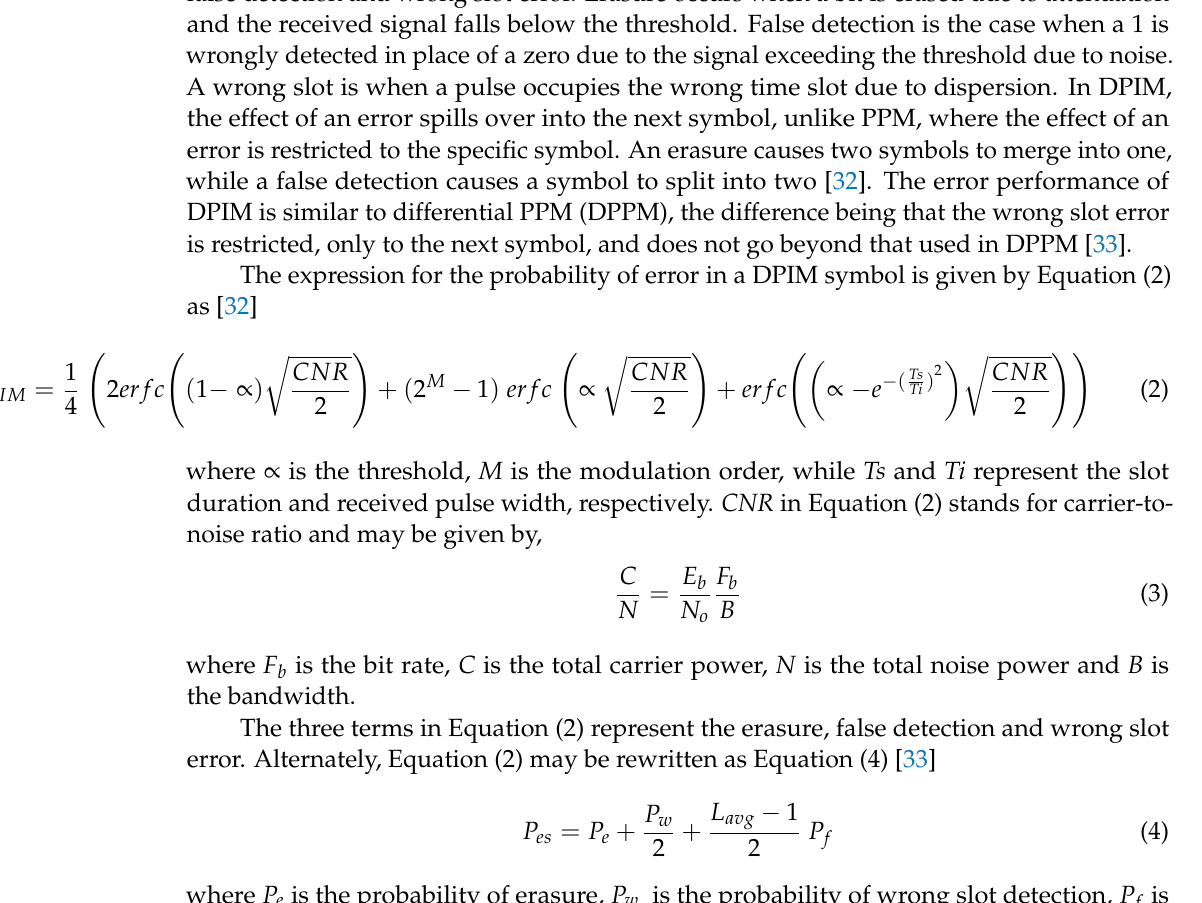
Figure 6. locations of ON subcarriers for 2-bit index data word ( a ) 00 ( b ) 01 ( c ) 10 ( d ) 11.